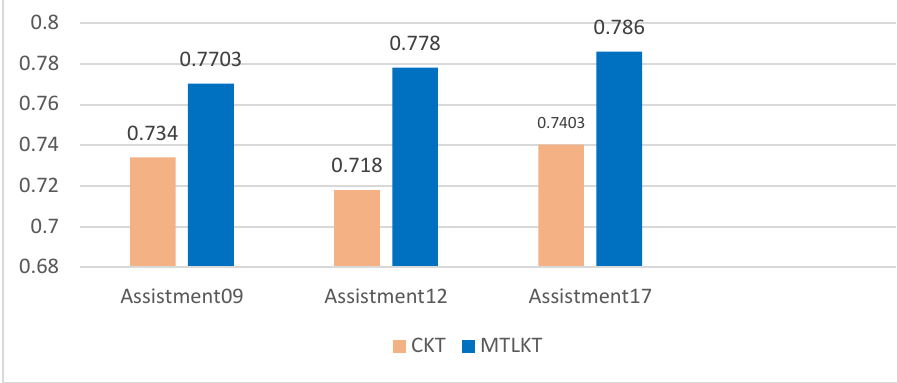
Figure 4. Comparison with convolutional-based model.